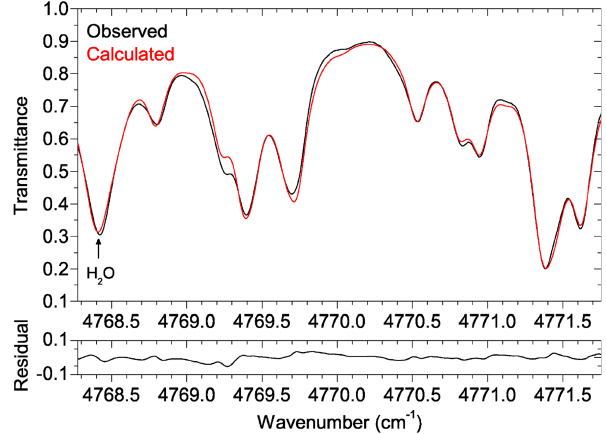
Fig. 5. Observed and calculated atmospheric transmittance spectra in the CH 4 region. All features arise from CH 4